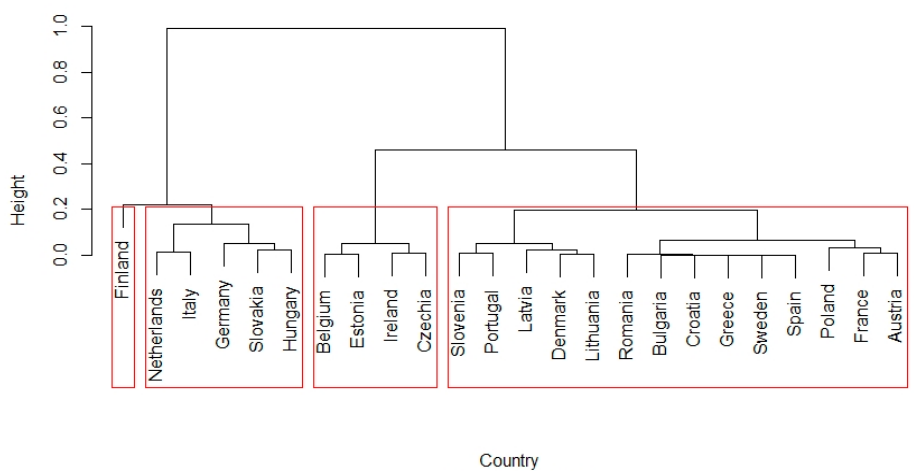
Figure 6. Cluster dendrogram of technical efficiency change (EffCh) between the years 2019 and 2013.